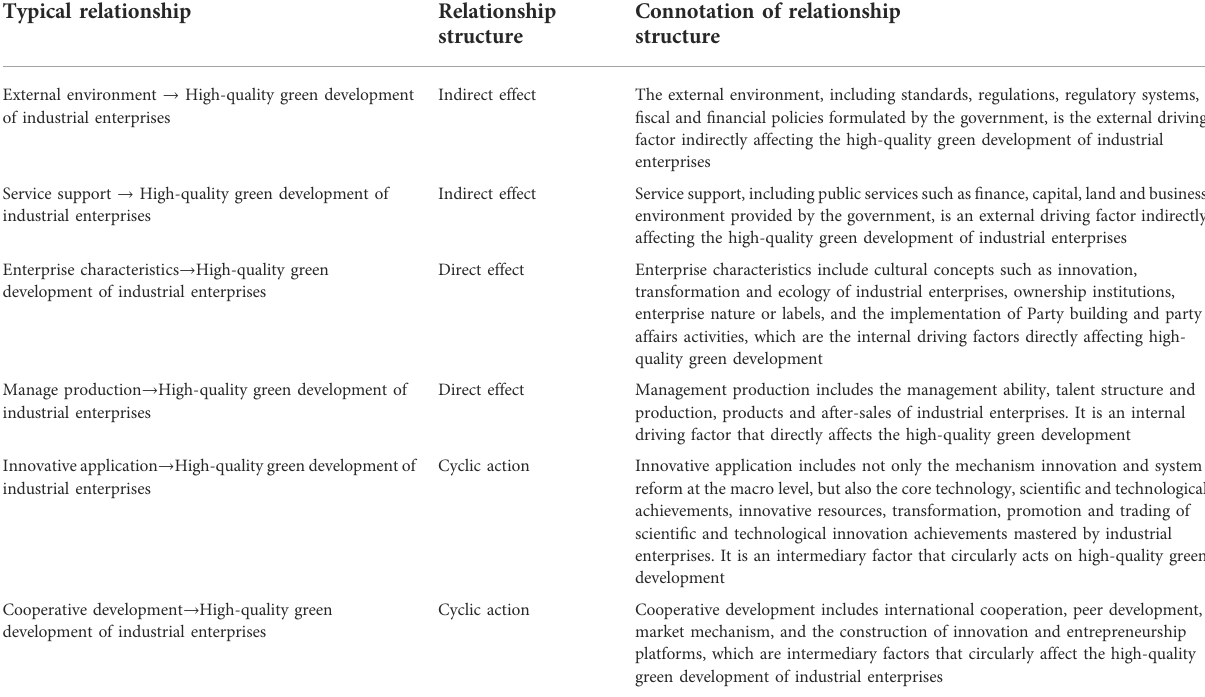
TABLE 6 Typical relation structure of the main